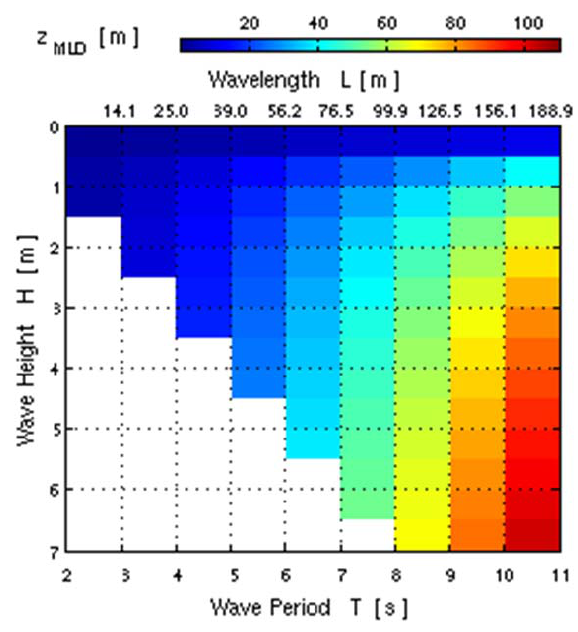
Fig. 3. Wave-induced mixed layer depth z MLD for the wave classes Fig. 3 : Wave ‐ induced mixed layer depth z under consideration (Eq. consideration (Eq. 3). 4